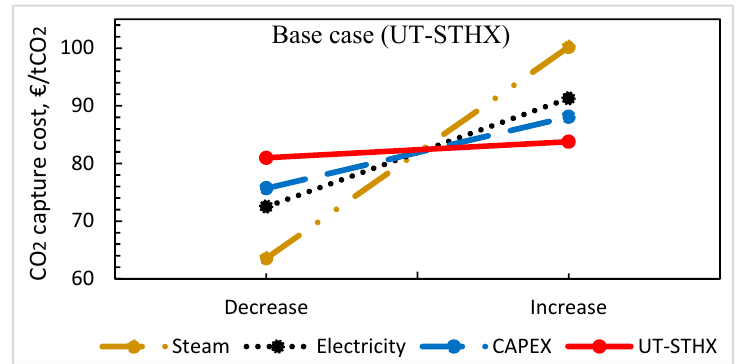
Figure 9. Sensitivity of important economic variables on the capture cost of the base case.